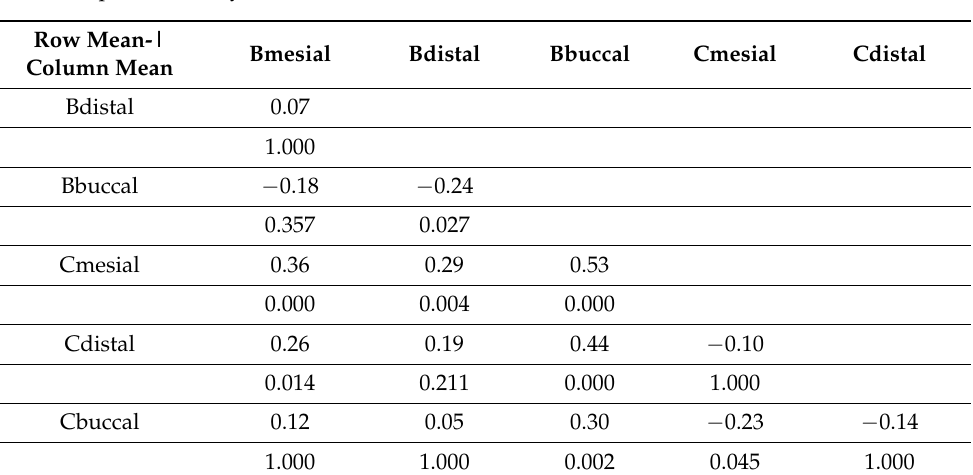
Table 4. A post hoc analysis (Bonferroni).